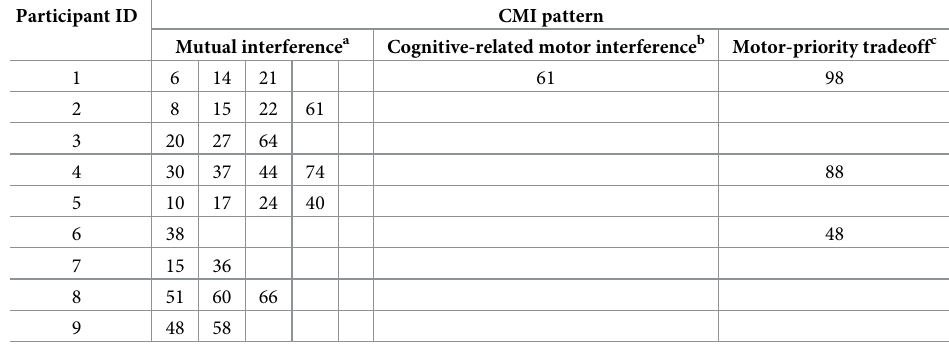
Table 3. Changes in the CMI pattern as a function of day since first cane use in each participant. Each number indicates the days since first cane use, for each testing session. Participant ID CMI pattern Mutual interference a